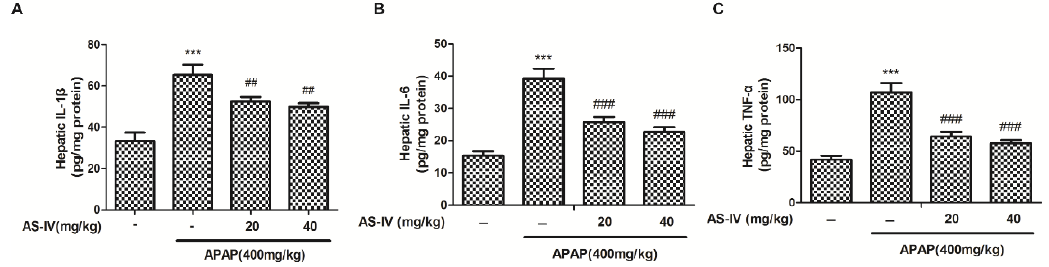
Figure 5. AS-IV repressed APAP-induced increase in hepatic inflammatory cytokines. After given APAP for 4 h, liver samples were harvested for IL-1β ( A ), IL-6 ( B ) and TNF-α ( C ) ELISA assay. Data were expressed as means ± SEM ( n = 10). *** p < 0.001 compared to vehicle control; ## p < 0.01, ### p < 0.001 compared to APAP.